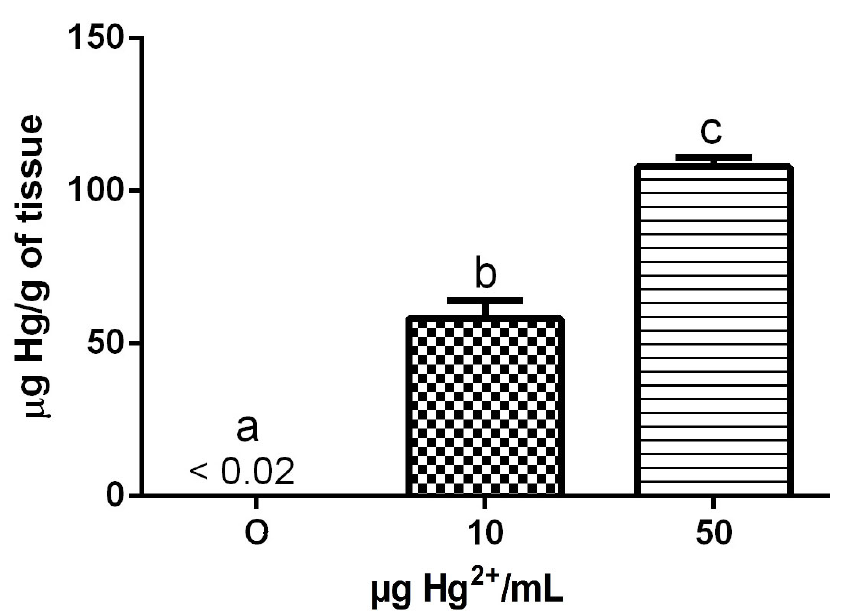
Figure 2. Renal Hg levels of dams exposed to different doses (0, 10 and 50 µ g Hg 2+ /mL) of HgCl 2 as described in Table 1. The results are presented as mean ± SEM. Groups with the same letters have no statistically significant difference and groups with different letters differ statistically (Tukey’s multiple range test; p < 0.05). 0 = 0 µ g Hg 2+ /mL group (control group); 10 = 10 µ g Hg 2+ /mL group; 50 = 50 µ g Hg 2+ /mL group.